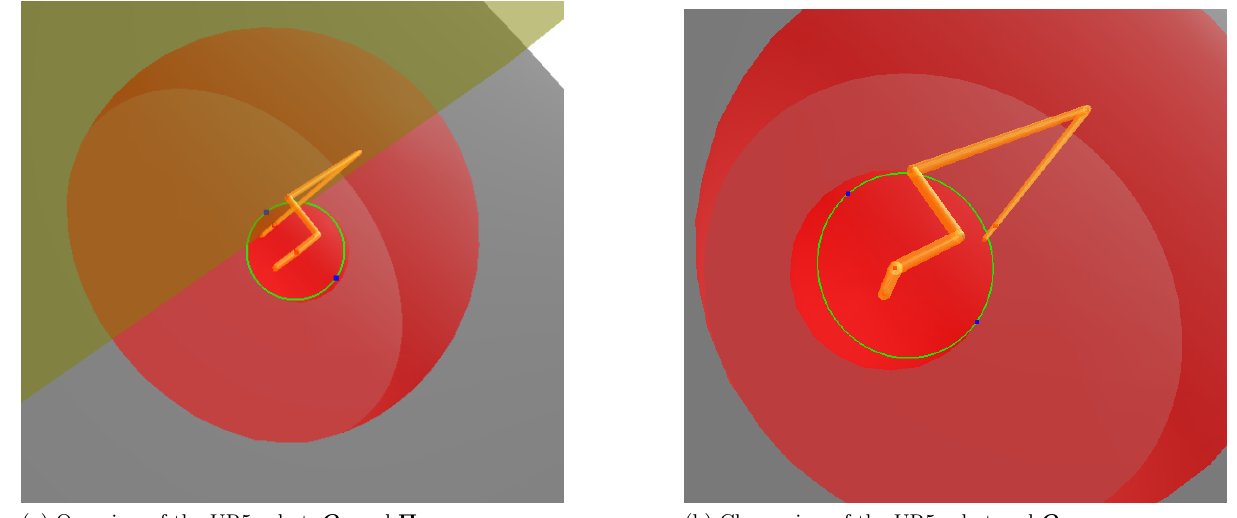
Figure 7: The red spheres are S c and K 0 , the green circle is C 5 k , Q c is the blue point pair, and Π c is the yellow